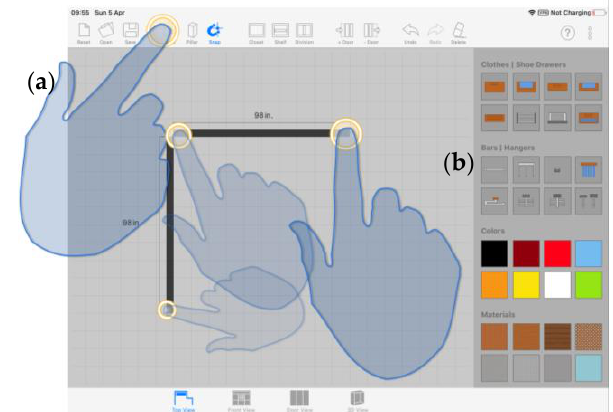
Figure 7. Room walls creation process: ( a ) single-tap-based wall creation tool activation and ( b ) consecutive single-taps for located element creation.